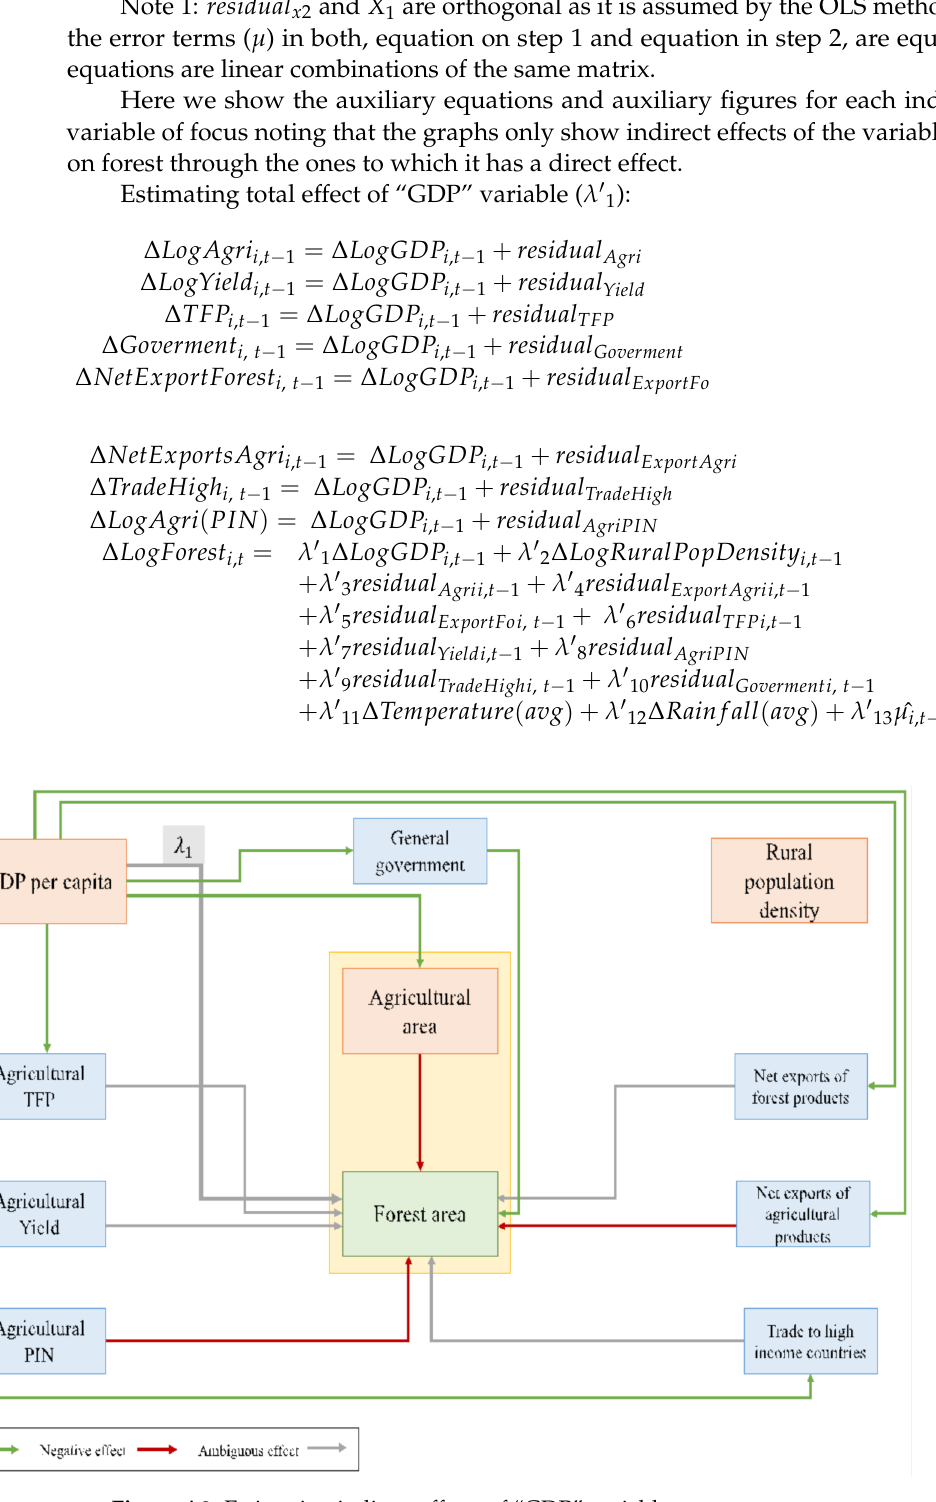
Figure A2. Estimating indirect effects of “GDP”